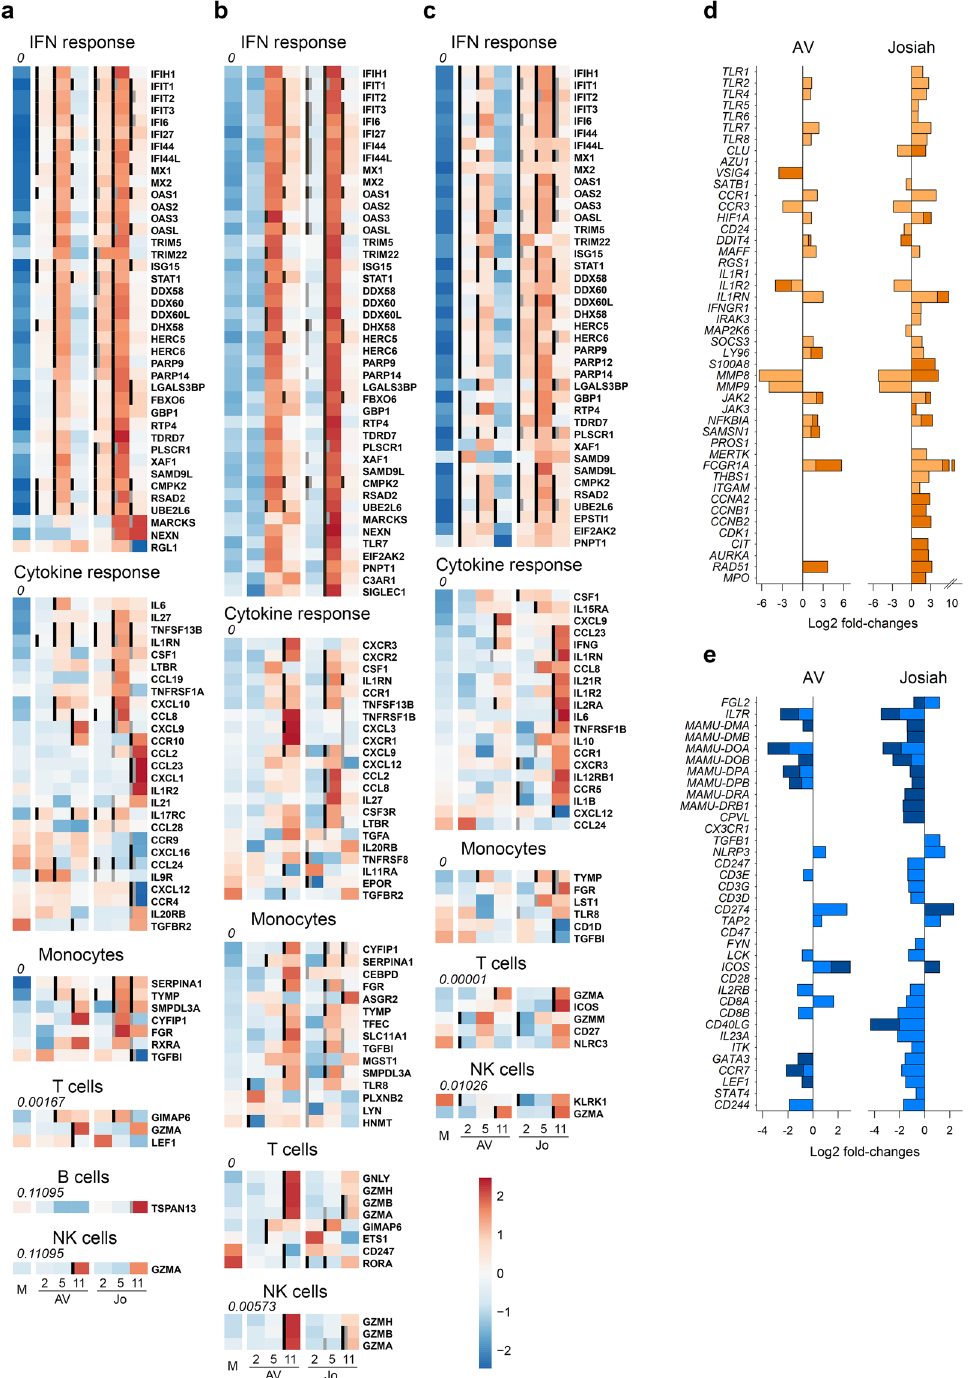
Fig. 9 Analysis of transcriptomic data of organs and of genes related to sepsis in PBMCs. Heatmap of gene expression of fi ve gene sets in spleen a MLN, b , and liver c presented as in Fig. 8b, except that only the DE genes are listed. Gene expression was standardized using VST transformation, hence centered and scaled to make the gene expression comparable. Each column corresponds to the mean gene expression of the three animals of each group for a given timepoint. The Log2 fold-changes of genes found DE in this study and known to be upregulated d or downregulated e in PBMCs during severe sepsis were calculated between PBMCs of LASV-infected and mock animals and represented by light and dark colors for 4 and 10 DPI,